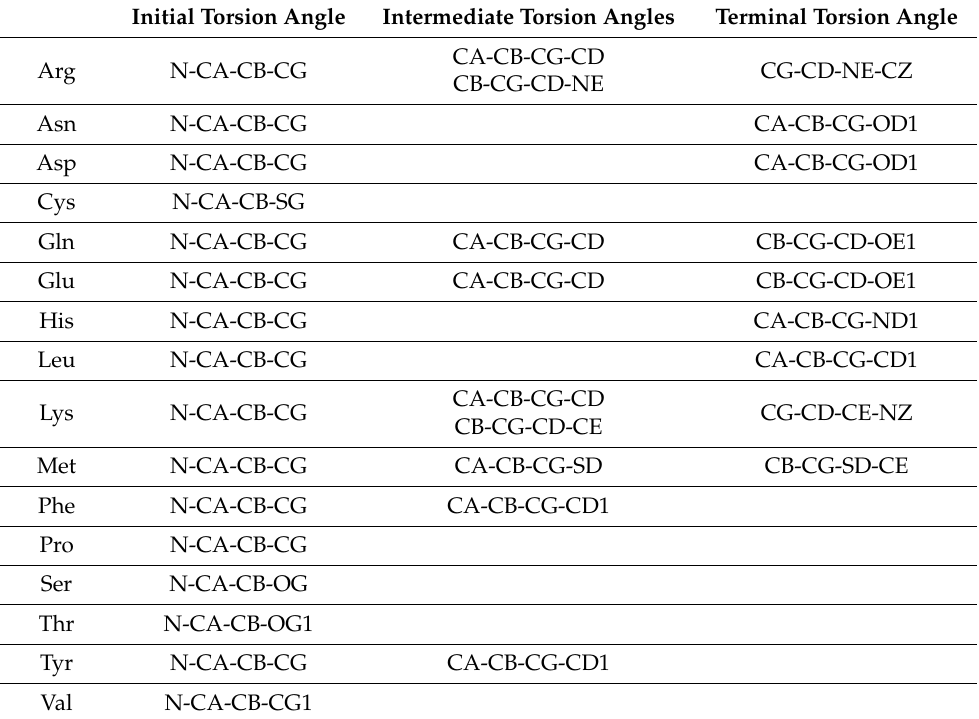
Table 2. Definitions of the torsion angles used for the calculation of χ i dihedral angles and the determination of side-chain